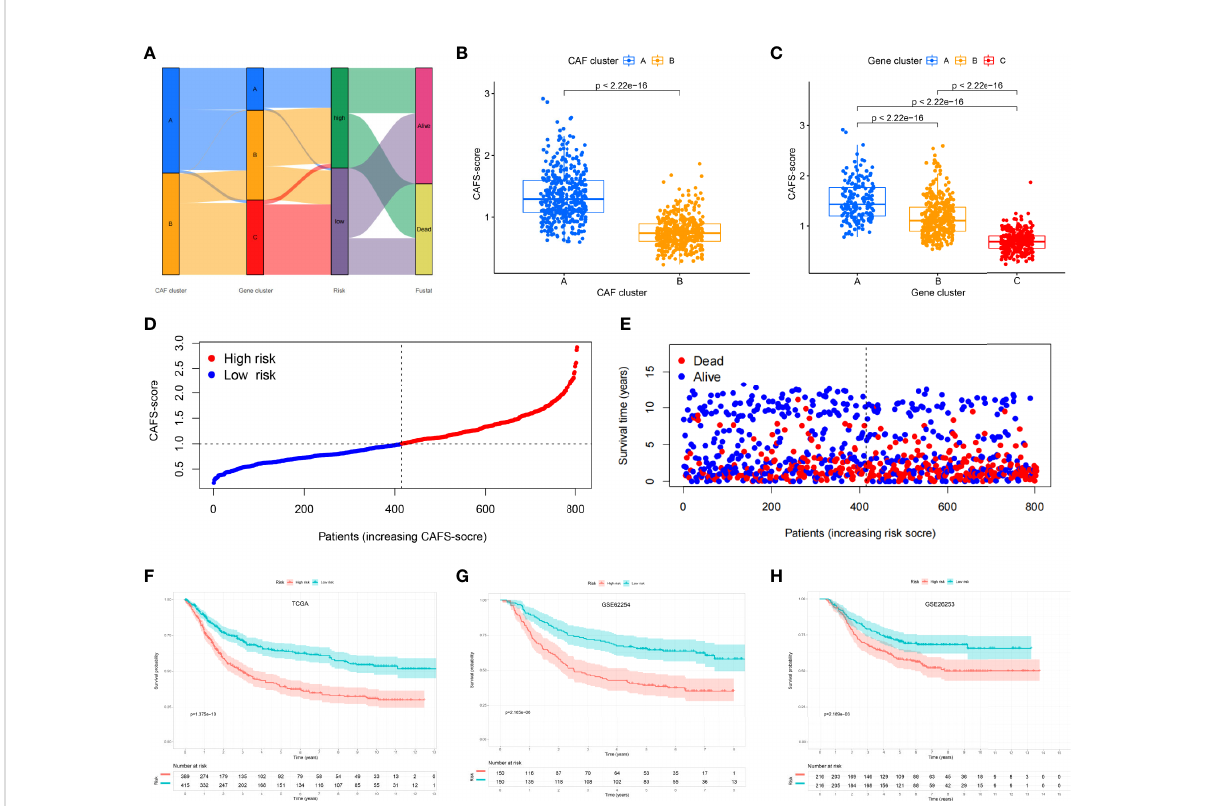
FIGURE 4 Establishment risk assessment model and survival outcomes in GC. (A) Alluvial diagram of the subtype distributions in groups with different CAFS-score and survival outcomes. (B) Differences in CAFS-score between two CAF subtypes. (C) Differences in CAFS-score between three gene subtypes. (D, E) Ranked dot and scatter plots representing the CAFS-score distribution and patient survival status. (F-H) Kaplan-Meier analysis of the RFS between the two risk groups in the TCGA, GSE62254, and GSE26253